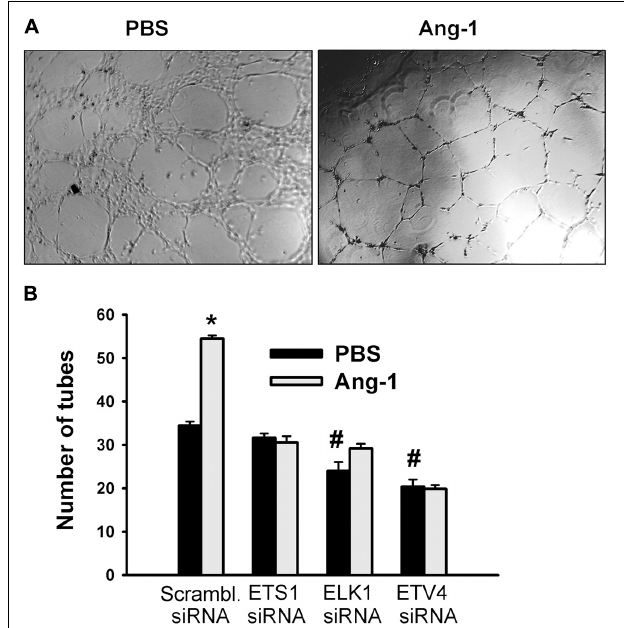
FIGURE 8 | ETS1, ELK1, and ETV4 contribute to Ang-1-induced EC differentiation. (A) Representative images of capillary-like tube formation of HUVECs transfected with siRNA oligos and maintained for 24 h on plates pre-coated with growth factor-reduced Matrigel and basic medium containing PBS or Ang-1. (B) Total tube number of HUVECs transfected with siRNA oligos and maintained for 24 h on plates pre-coated with growth factor-reduced Matrigel and basic medium containing PBS or Ang-1. Values are means ± SEM. N = 8 per group. * P < 0.05, compared to PBS. # P < 0.05, compared to scrambled siRNA oligo-transfected cells treated with PBS.